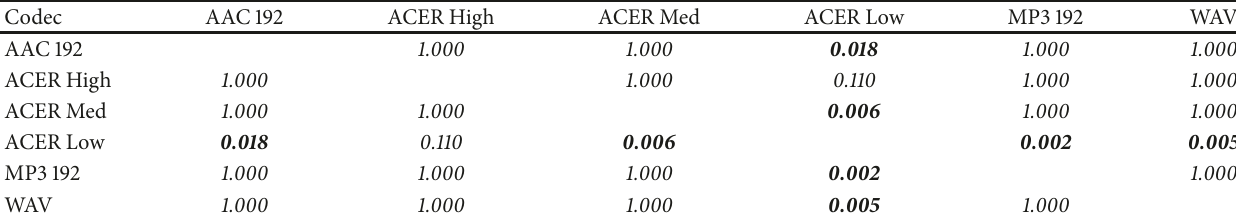
Table 5: Post hoc pairwise codec comparisons (p values < 0.05 are highlighted in